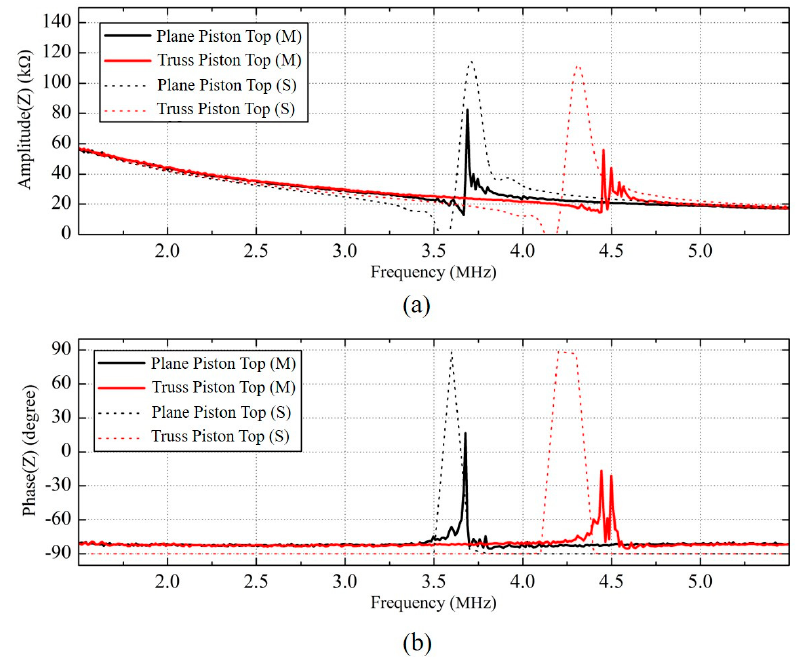
Figure 5. Electrical input impedance measurement results of the plane and truss 2D CMUTs biased at 40 V DC in air: ( a ) the amplitude part and ( b ) the phase part. The dotted line represented the ANSYS simulation results of each type of the CMUTs.